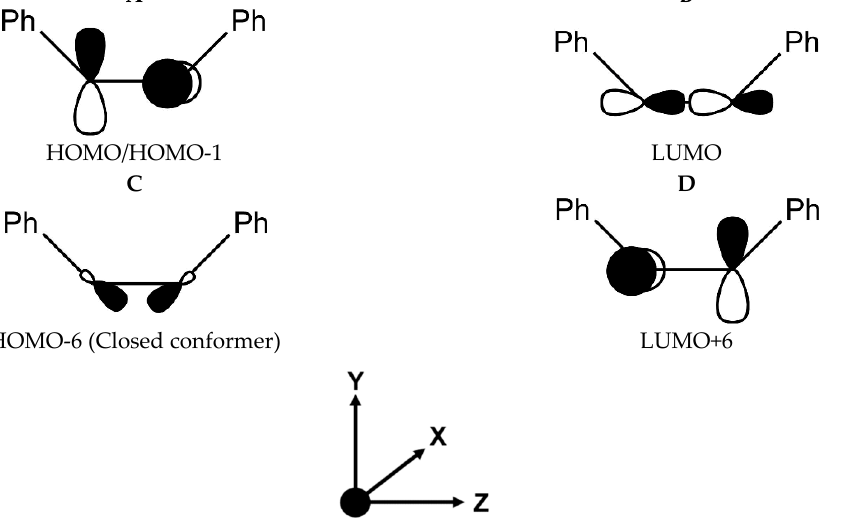
Figure 5. Most important inner and outer valence molecular orbitals (MOs) of Ph 2 Te 2 : HOMO/HOMO-1 ( A ), LUMO ( B ), HOMO-6 of the closed conformer ( C ) and LUMO+6 ( D ) Unless otherwise specified, the spatial part of the MOs is equal for both the conformers (open and closed).